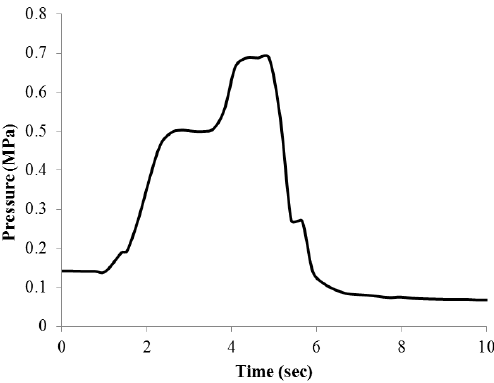
Figure 5. The characteristic response of MS to a failure IDP event (in MPa) as function of time (in